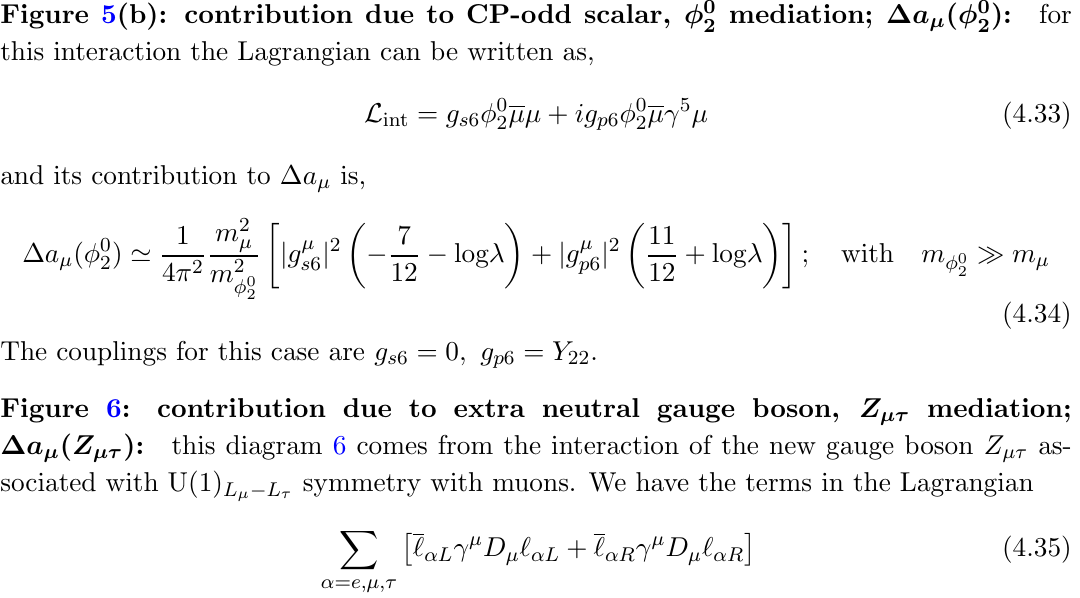
mediation; (cid:1) a ( (cid:30) 0 ): (cid:22) 2 2